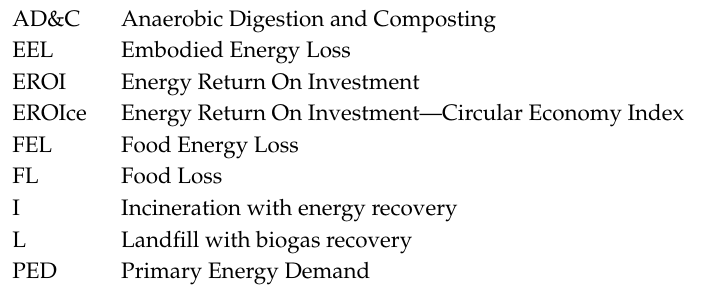
Laso et al., Table S4: Results in MJ/cap/day of the embodied energy loss and in kJ/cap/day of the food energy loss by each food category under study, on each stage, Table S5: Proteins, carbohydrates and energetic content for the food categories under study. Table S6: Allocation and conversion factors used for calculating the edible part of food production which is used for human consumption, Table S7. Food losses percentages for each food category as a percentage of what enters on each supply chain stage. Unless stated otherwise, percentages are obtained from Garcia-Herrero et al. and Gustavsson et al. for Europe region, Table S8: Results of the Energy return on investment–Circular economy index ( EROI ce ) on fish and seafood, cereals, vegetables and meat, on each of the considered